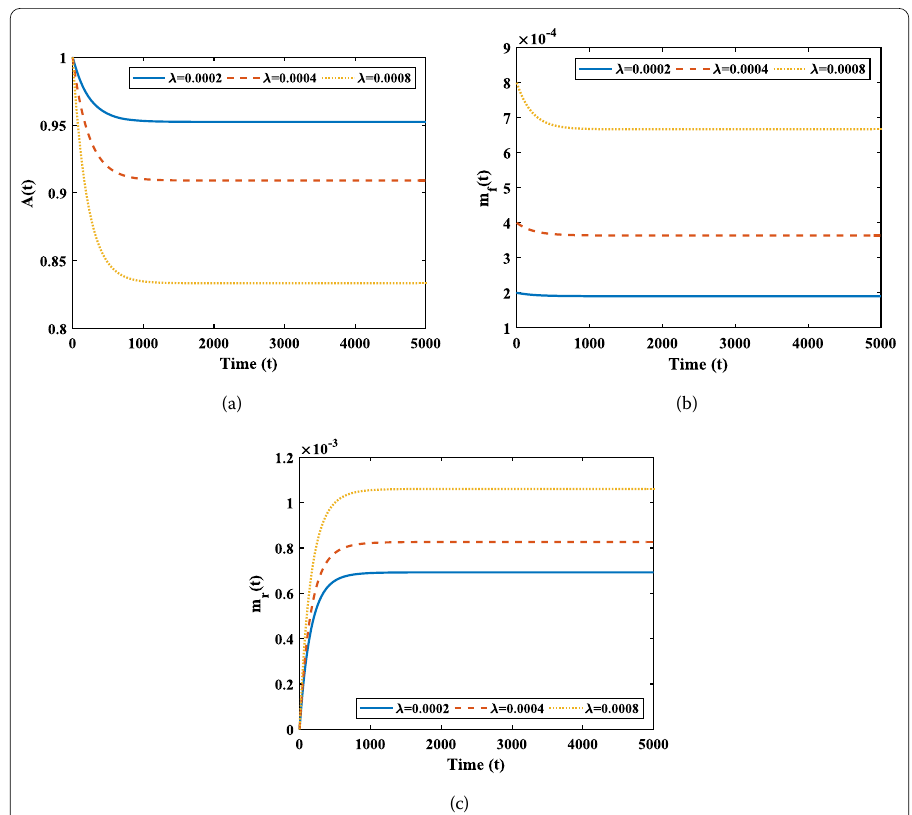
Figure 3 Time-dependent reliability indices with varying λ for exponentially distributed repair time. ( a ) Availability for different λ ; ( b ) Failure frequency for different λ ; ( c ) Renewal frequency for different λ